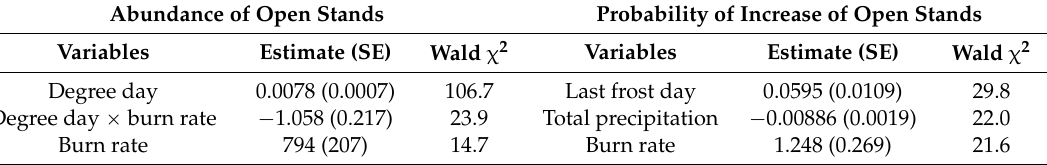
Table 2. List of variables selected with logistic regression to explain the variability of abundance of open stands by fire zones and increase in open stands after 150 years of simulations with a forest succession model in interaction with natural